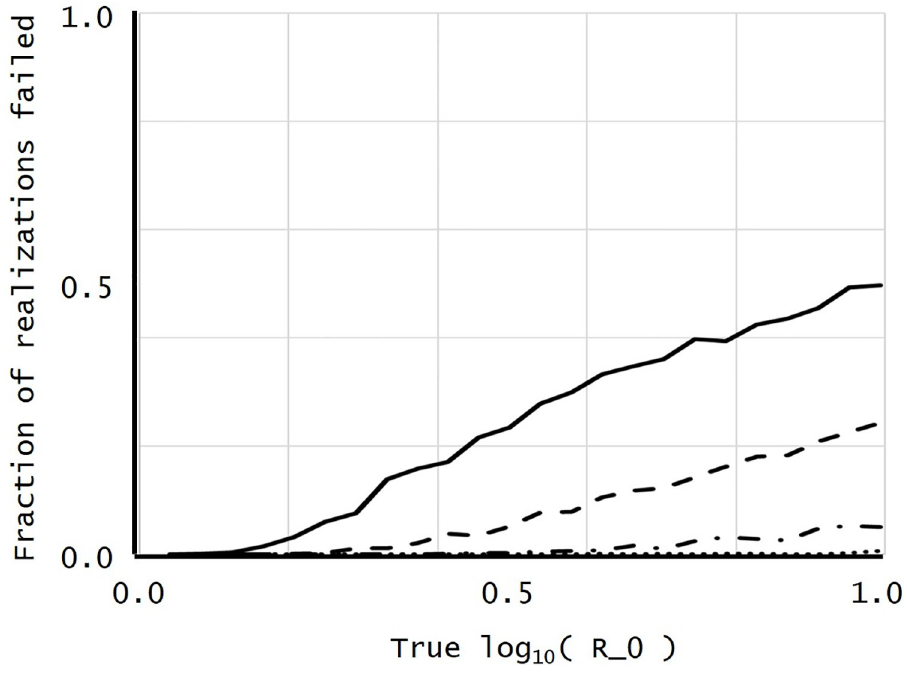
Fig 1. Plot of the fraction of realizations failed against the true log 10 r